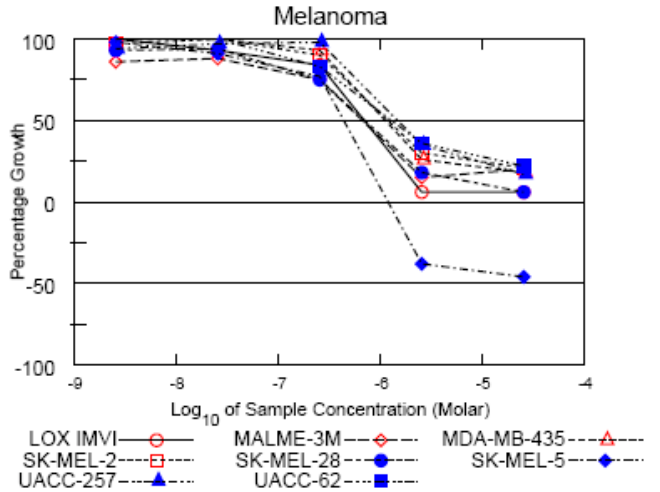
Figure 2. Compound 3c has affected the growth present of the melanoma cell line, SK-MEL-5, with a GP value of − 46.